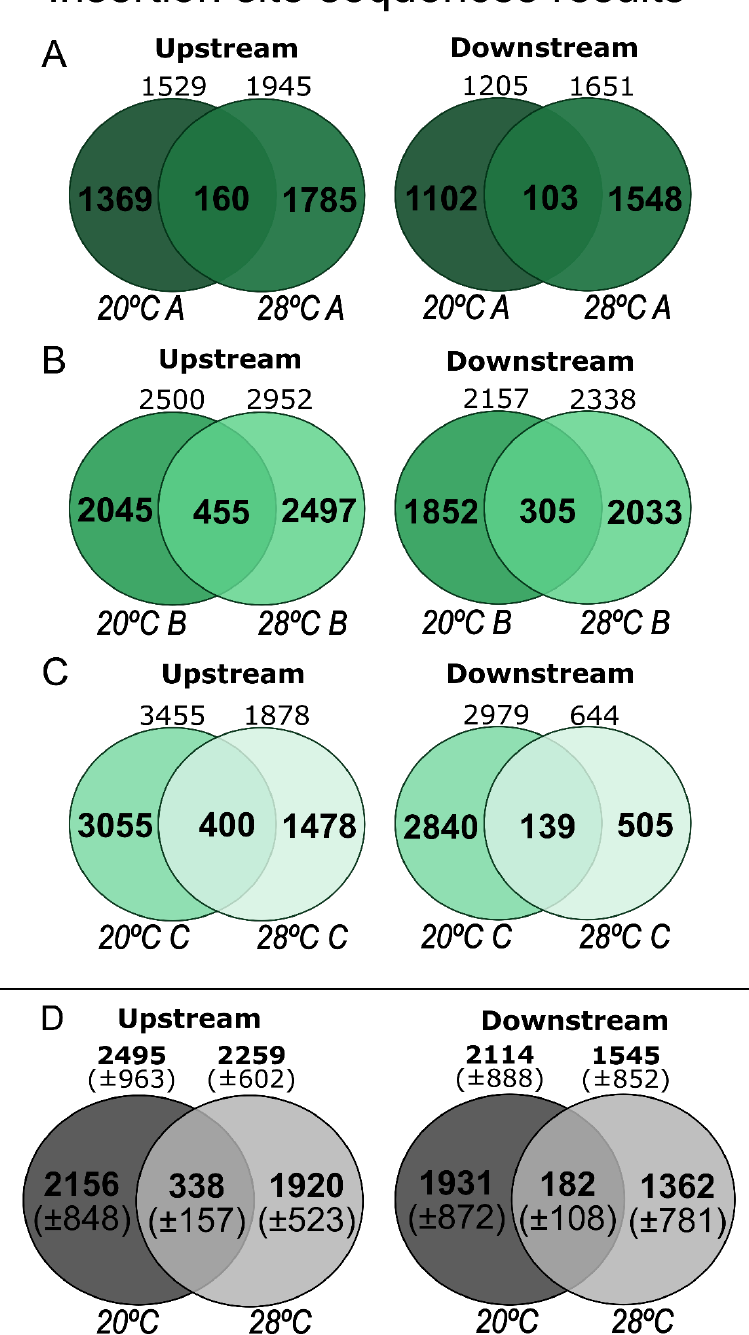
Figure 4. ISSs results. ( A – C ) Comparison between the 20 and 28 °C treatments in three replicates of the two ends of the element (upstream and downstream). Venn diagrams indicate the amount of sample fragments, what is unique to one or the other, and what is shared. ( D ) Means and standard deviations of the replicates.